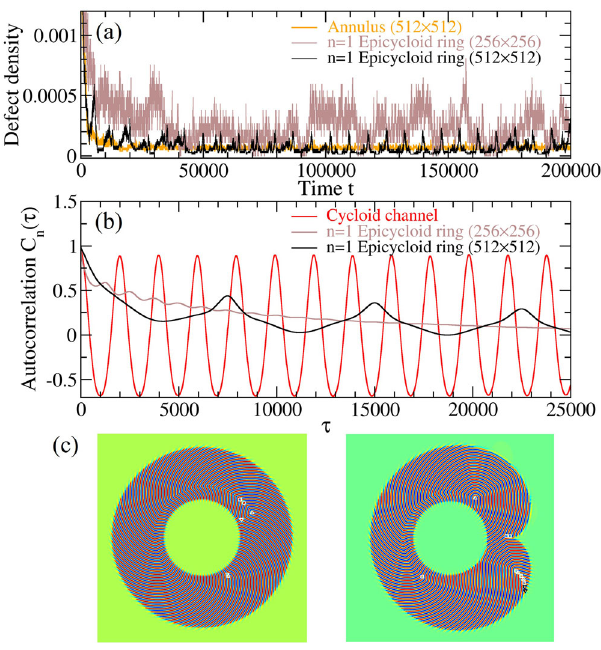
Fig. 7 Defect density and time correlation for channels and rings. a Sample time evolution of defect number density for annulus and single- cusp epicycloid rings of two different simulation system sizes at v 0 = 0.31. b Autocorrelation C n ( τ ) corresponding to the sample simulation of cycloid channel given in Fig. 6 and for n = 1 epicycloid rings (averaged over 80 simulation runs at t = 10 5 – 10 6 for each system size). c Sample snapshots of the annulus and one-cusp epicycloid ring